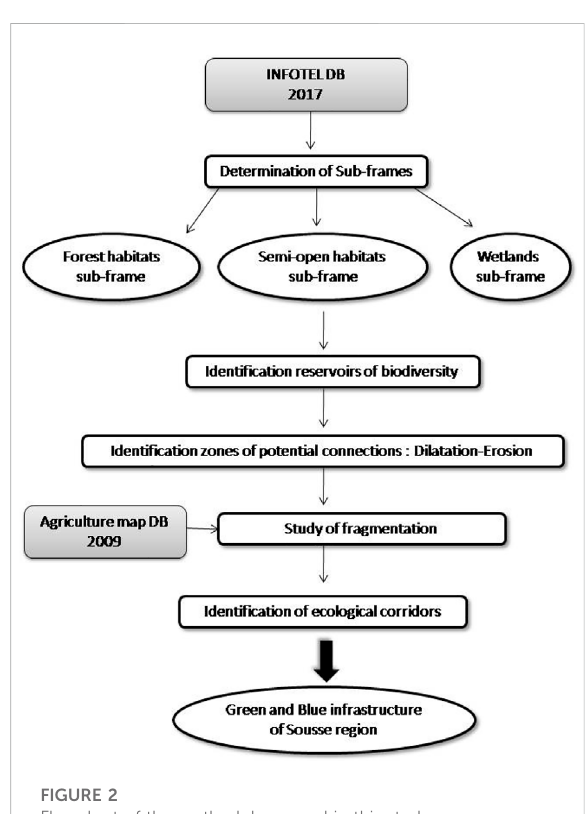
FIGURE 2 Flowchart of the methodology used in this